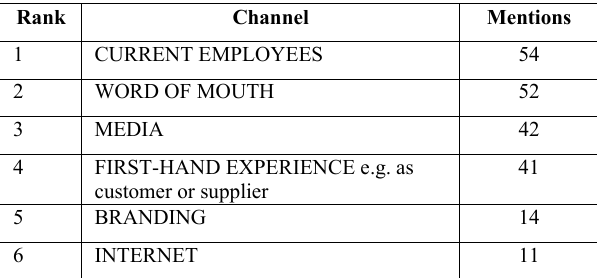
Table 2: Ranked list of communication channels